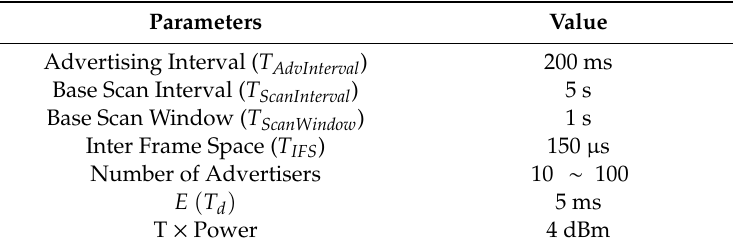
Table 1. Simulation